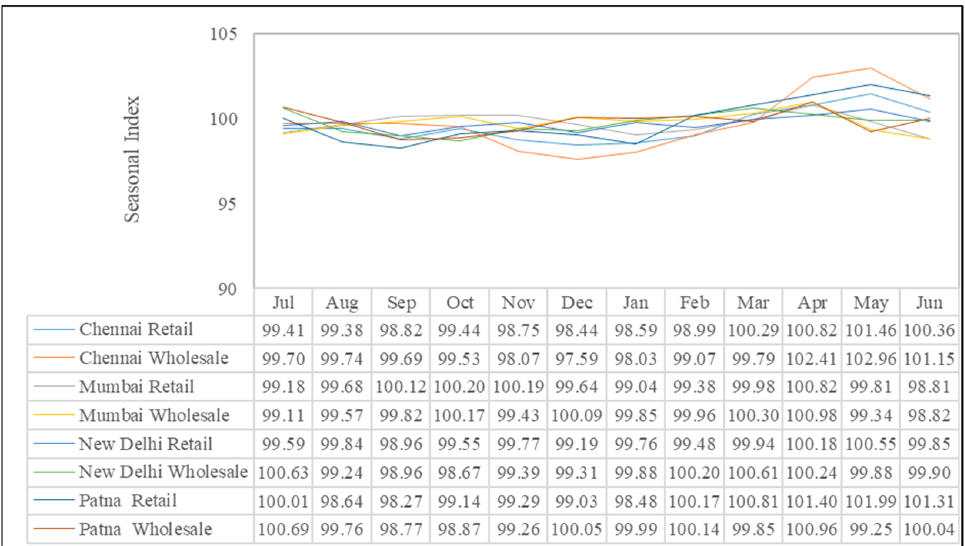
Figure 3. Seasonal price variations in rice markets .